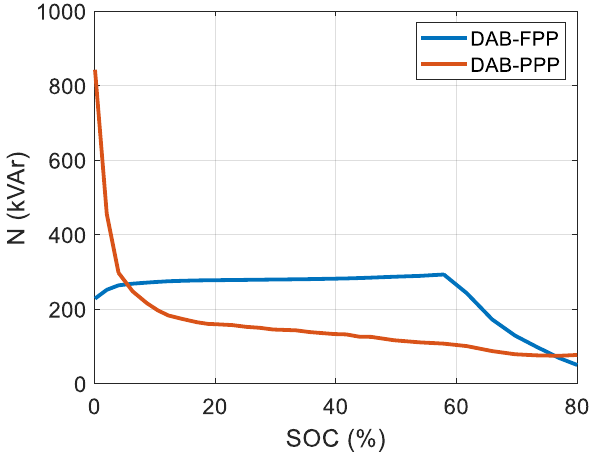
Figure 9. Processed non-active power comparison between the DAB-FPP and the DAB-PPP.